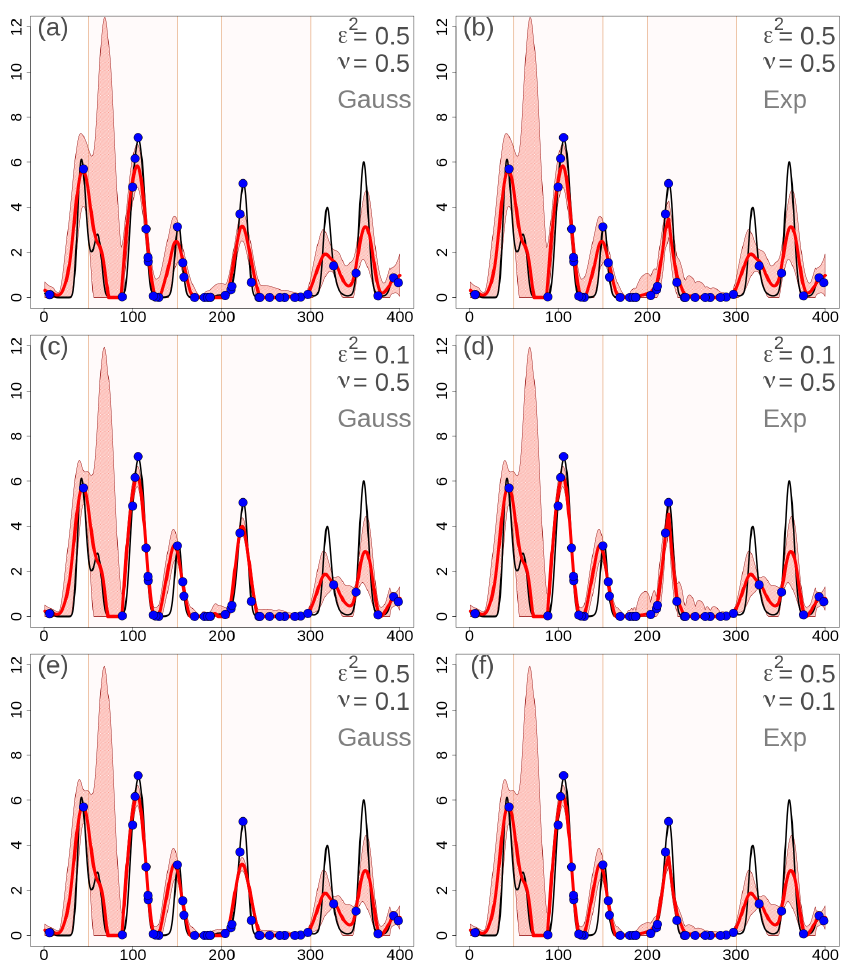
Figure 5. One-dimensional simulation in the original precipitation space (in millimeters). Analyses at grid points with different EnSI-GAP configurations, without applying the data transformation. The layout is the same as in Fig.